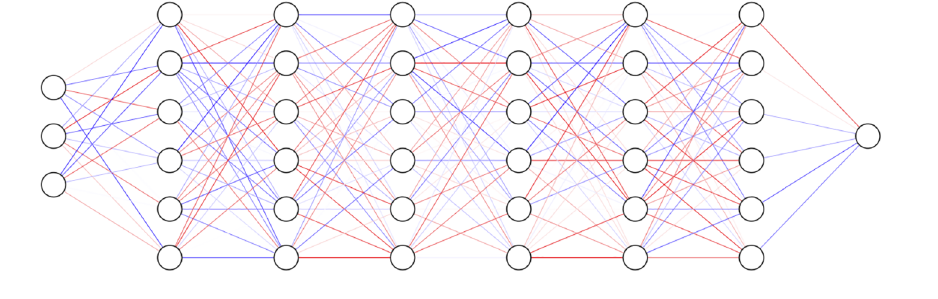
Figure 3. Artificial neural network (ANN) architecture. The initial layer receivesthe three vitalsof the patient, and the output node returns the operation point that controls the amount of delivered